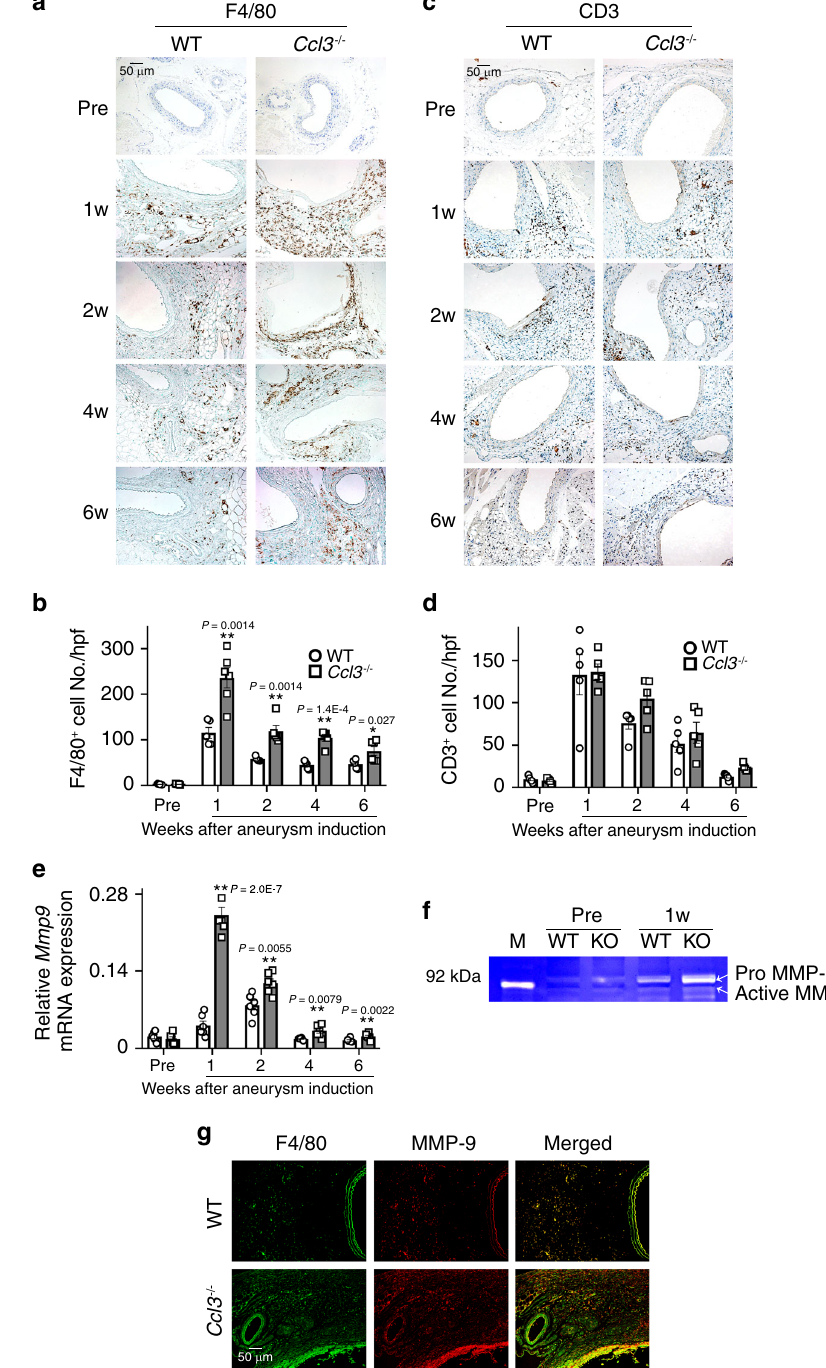
Fig. 2 Leukocyte recruitment and MMP-9 expression in the aortas after CaCl 2 treatment. a , c The accumulation of macrophages ( a ) and CD3 + T cells ( c ) into aortic tissues in WT and Ccl3 − / − mice. Representative results from six independent experiments. Scale bar, 50 µ m. b , d The numbers